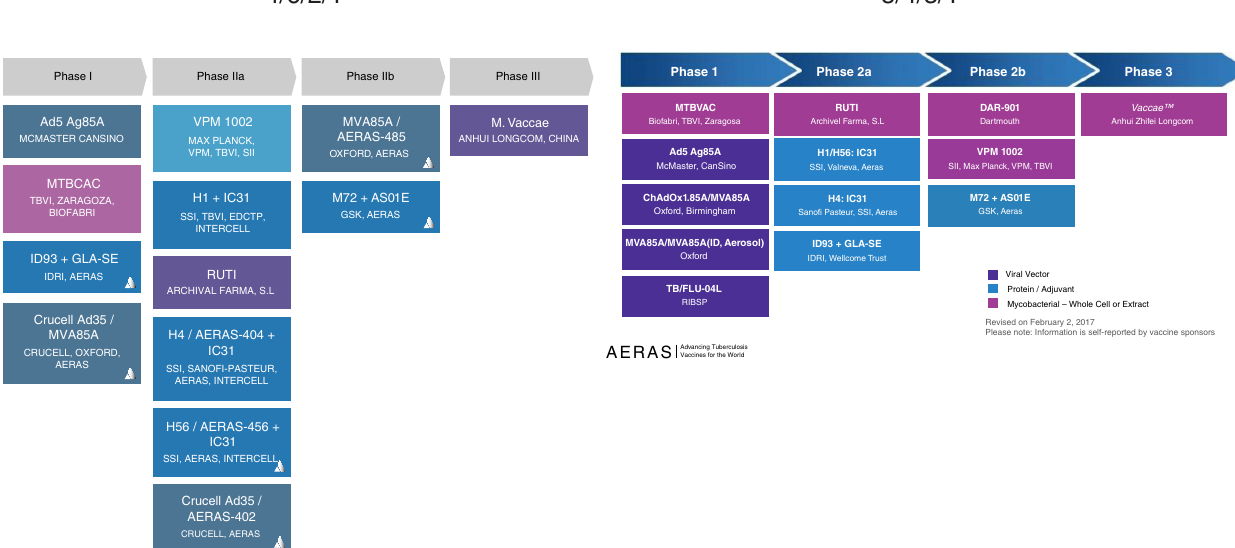
However, in large scale screening experiments antigens that induce a CD8+ T cell response have been identified and can be used with CD8+ T cell inducing vectors to specifically boost a CD8+ T cell response 16,17 . There are also platforms and antigens that promote an antibody response or an unconventional T cell response 10,18,19 . The broader range in antigen choice has been matched with the development of novel adjuvants, including synthetic and bio-inspired molecules, which mimic naturally occurring cellular processes for more efficient delivery of vac- cine components to the cell. The selected adjuvant can direct the immune response induced and the vaccine developer now has the option of driving immunity towards TH1, TH2, TH17 with the adjuvant selected 20